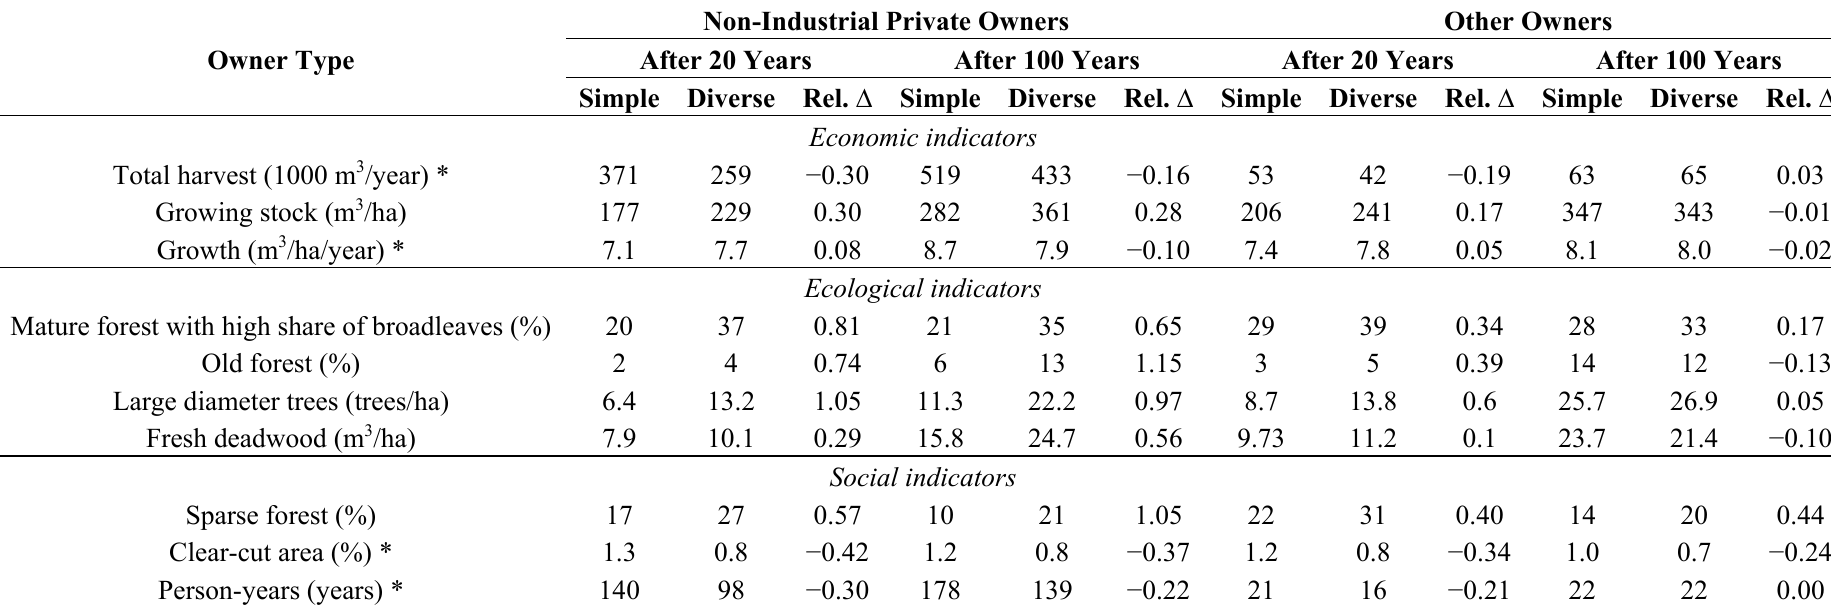
Table 12. Differences between the Diverse and Simple scenarios for economic, ecological and social indicators after 20 and 100 years of simulation, by ownership category, in Hässleholm. The relative differences (Rel. ∆) were calculated as: (Diverse-Simple)/Simple. See Table 2 for information on the proportion of different owner